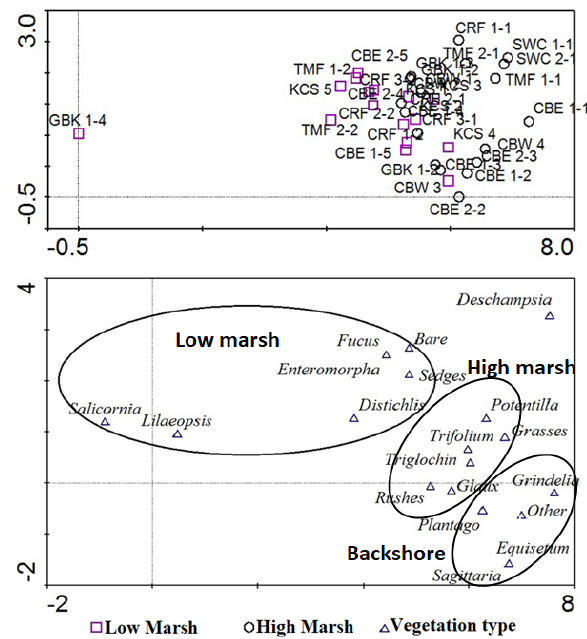
Figure B1. Detrended correspondence analysis results for marsh vegetation data. Low marsh cores (top, purple squares) corre- sponded reasonably well with vegetation identified as low marsh and high marsh cores corresponded with a distinct cluster of high marsh vegetation. The far bottom right may indicate a population of less salt-tolerant, upland vegetation, but it is indistinct from the high